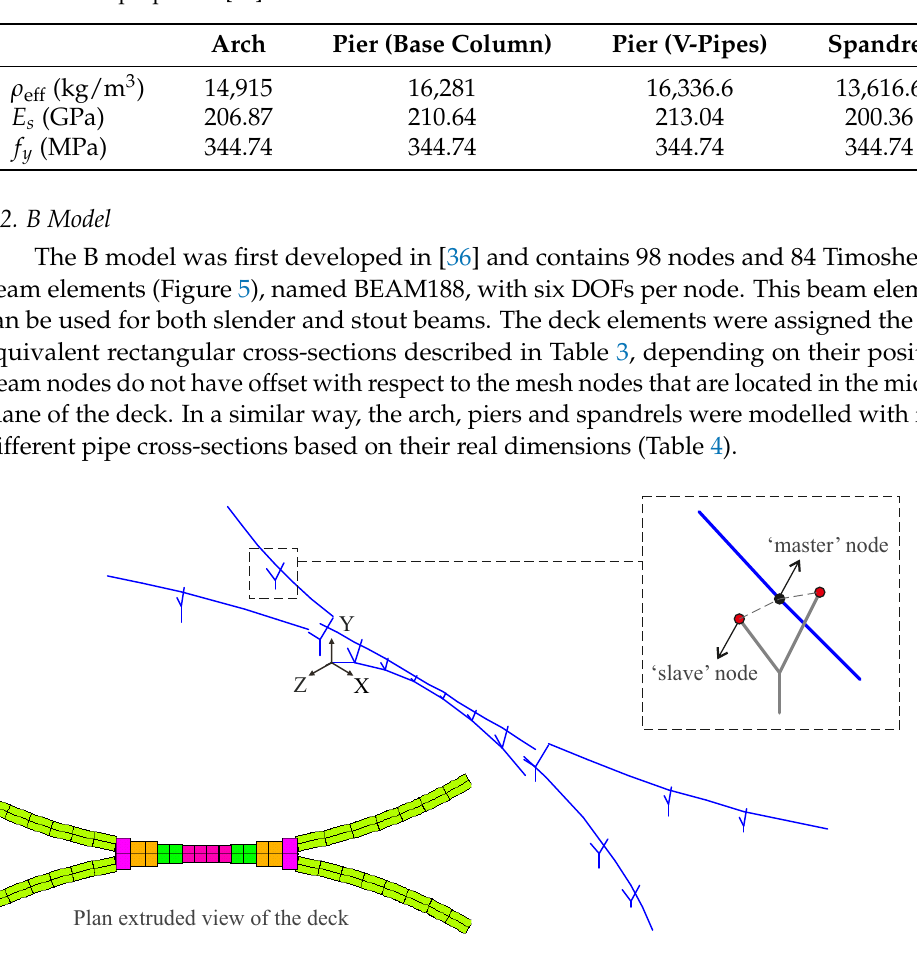
Figure 5. B model, with zoom on the pier–deck connection and deck cross